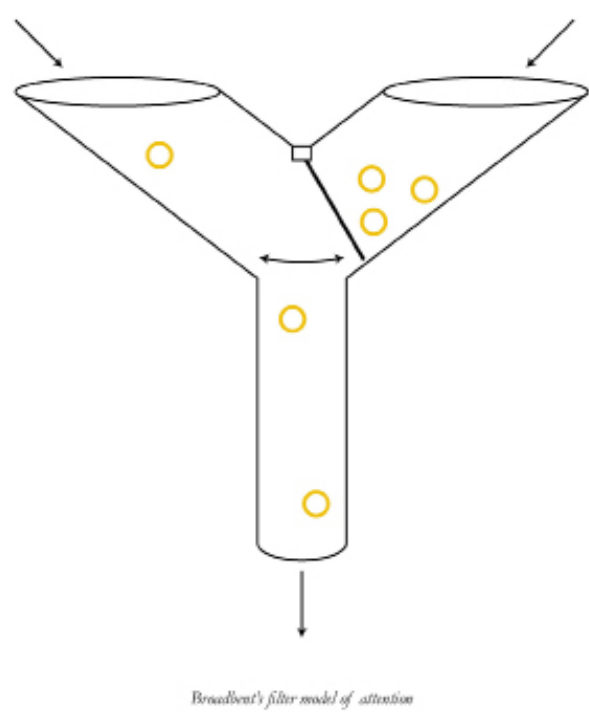
Fig. 4 Zambonini A.,